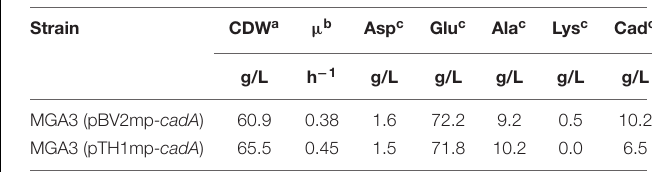
imported from Nærdal et al. (2015). CDW, cell dry weight; µ , specific growth rate; Asp, L -aspartate; Glu, L -glutamate; Ala, L -alanine; Lys, L -lysine; Cad, cadaverine. a Biomass concentrations are maximum values from the stationary growth phase. b Specific growth rates are maximum values calculated from the exponential growth period. c Cadaverine and amino acid concentrations are maximum values and volume